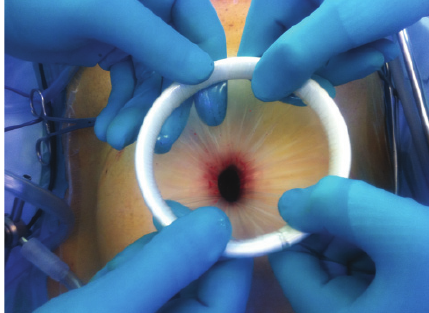
Figure 1: Placement of wound protector.